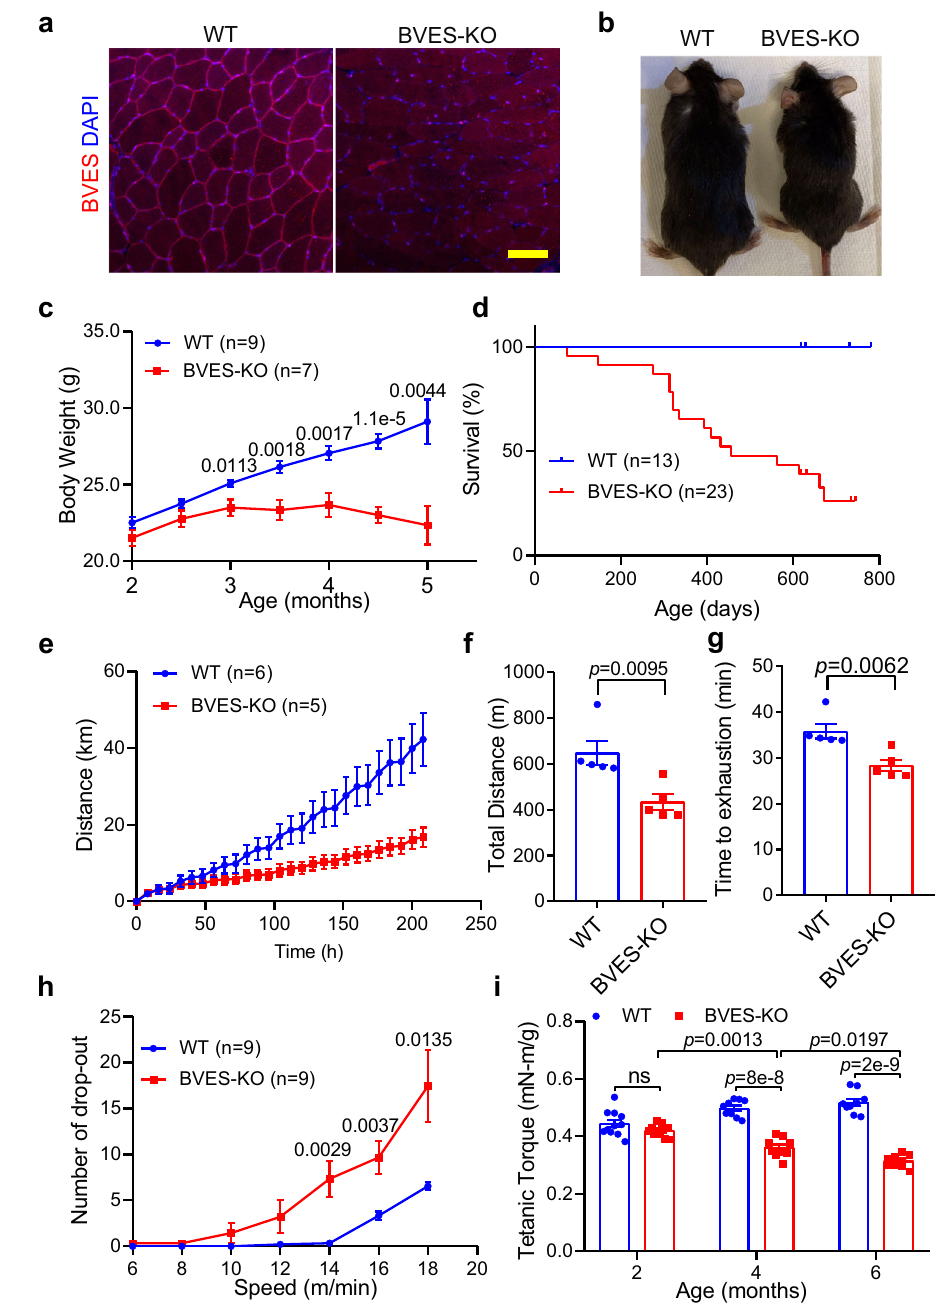
Fig. 1 | BVES disruption compromises the body weight gain and muscle func- tion in mice. All animal experiments were performed in WT and BVES-KO male micewiththe C57BL/6Ngeneticbackground. a Immuno fl uorescenceimagesof GA muscles in WT and BVES-KO mice (4 months of age) stained with the antibody against BVES and DAPI. Scale bar: 100 µ m. ( n =4 per genotype). b Representative imageofWTandBVES-KOmalelittermatesat4monthsofage. c ,Bodyweightgain of male BVES-KO and age/sex-matched WT mice from two to fi ve months of age. Two-tailed paired Student ’ s t test. d Kaplan – Meier survival curve of WT and BVES- KO male mice. e Voluntary wheel running of BVES-KO and age-matched WT male mice (4 months of age). f , g Endurance capacity test performed by treadmill